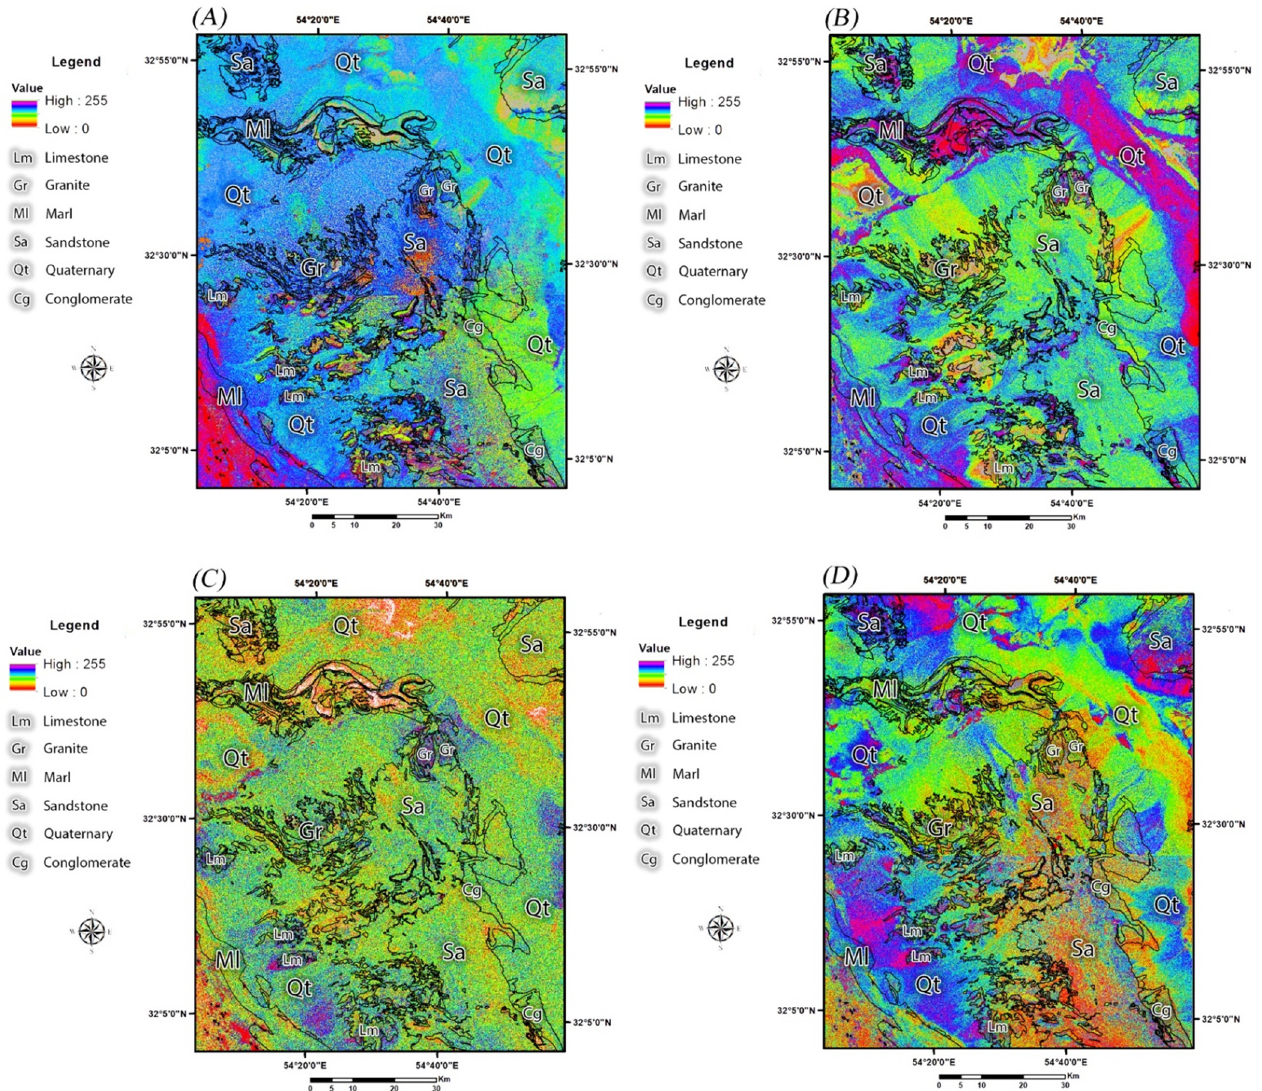
Figure 6. Spatial distribution of iron oxide/hydroxides and hydroxyl-bearing (Al-OH) alteration and carbonates in the study area as pseudo-color ramp. ( A ) LS-Fit residual band 4 of Sentinel-2; ( B ) LS-Fit residual band 12 of Sentinel-2; ( C ) LS-Fit residual band 3 of Landsat-7; ( D ) LS-Fit residual band 7 of Landsat-7.